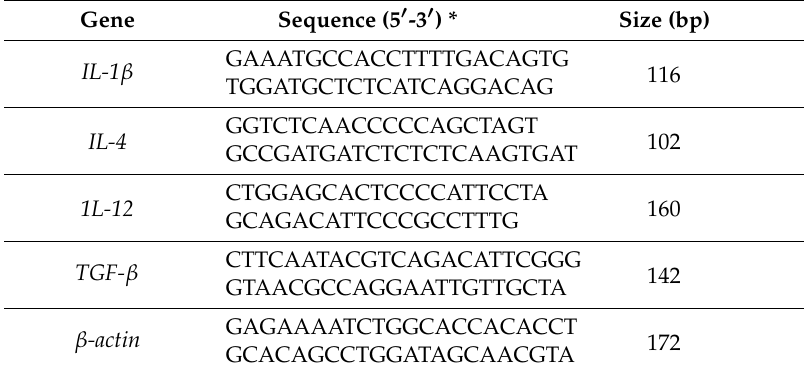
Table 1. Primer sequences used for